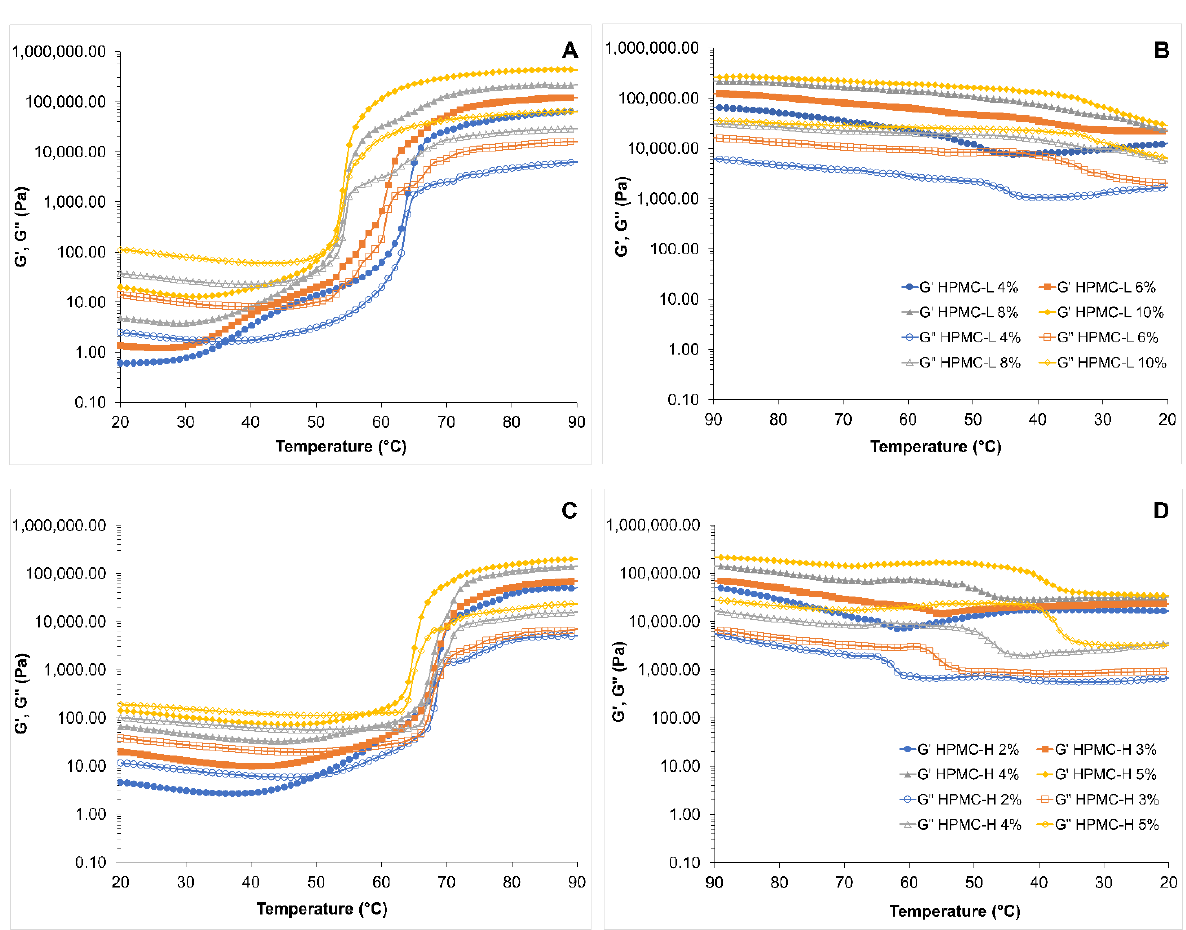
Figure 2. G’ and G” moduli of HPMC solutions as a function of temperature. ( A ) temperature ramp up for HPMC-L; ( B ) temperature ramp down bot HPLC-L; ( C ) temperature ramp up for HPMC-H; ( D ) temperature ramp down bot HPLC-H. Filled symbols correspond to elastic modulus (G’) and open symbols to viscous modulus (G”). Frequency = 1 Hz, heating rate = 1 °C/min.